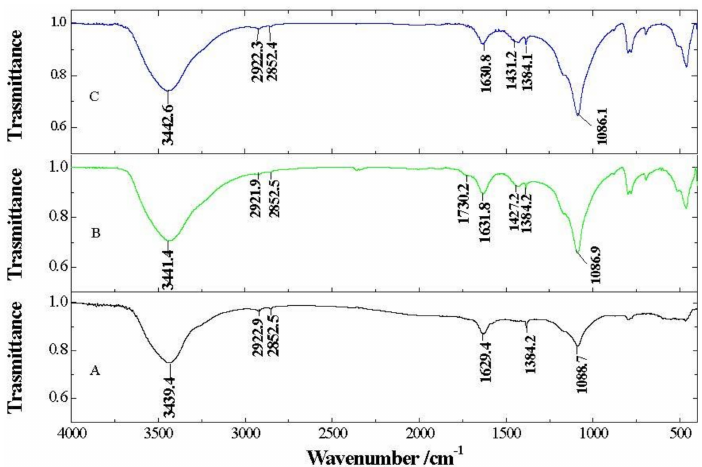
Figure 3. FT-IR spectra of xGnP ( A ), xGOnP ( B ), and r-xGOnP ( C